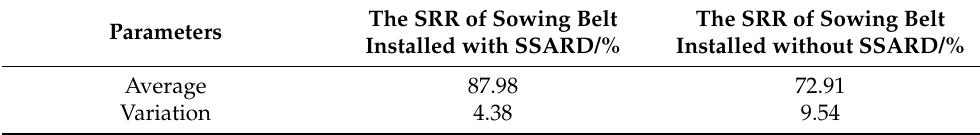
Table 6. Field test results of straw cleaning effect of sowing